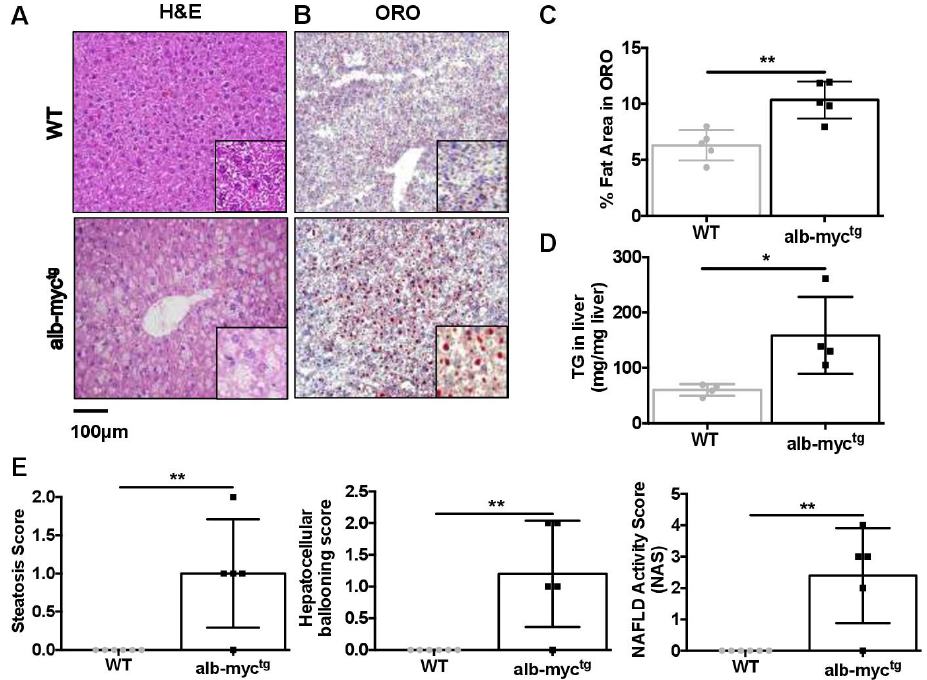
Figure 3. Steatotic changes in the liver of transgenic mice. ( A ) Representative liver H&E staining demonstrating distended hepatocytes with foamy appearing cytoplasm and small lipid vesicles. Scale bar = 100 µ m ( n = 8–9). ( B ) Illustrative ORO staining. Scale bar = 100 µ m. ( C ) Quantitative analysis of ORO-stained area ( n = 5). ( D ) Direct TG quantification ( n = 4). ( E ) Histology score for steatosis, hepatocyte ballooning, NAFLD activity score (NAS) ( n = 5–6). Data are expressed as the mean ± SD, * = p < 0.05; ** = p < 0.01, alb-myc tg mice vs. WT controls.